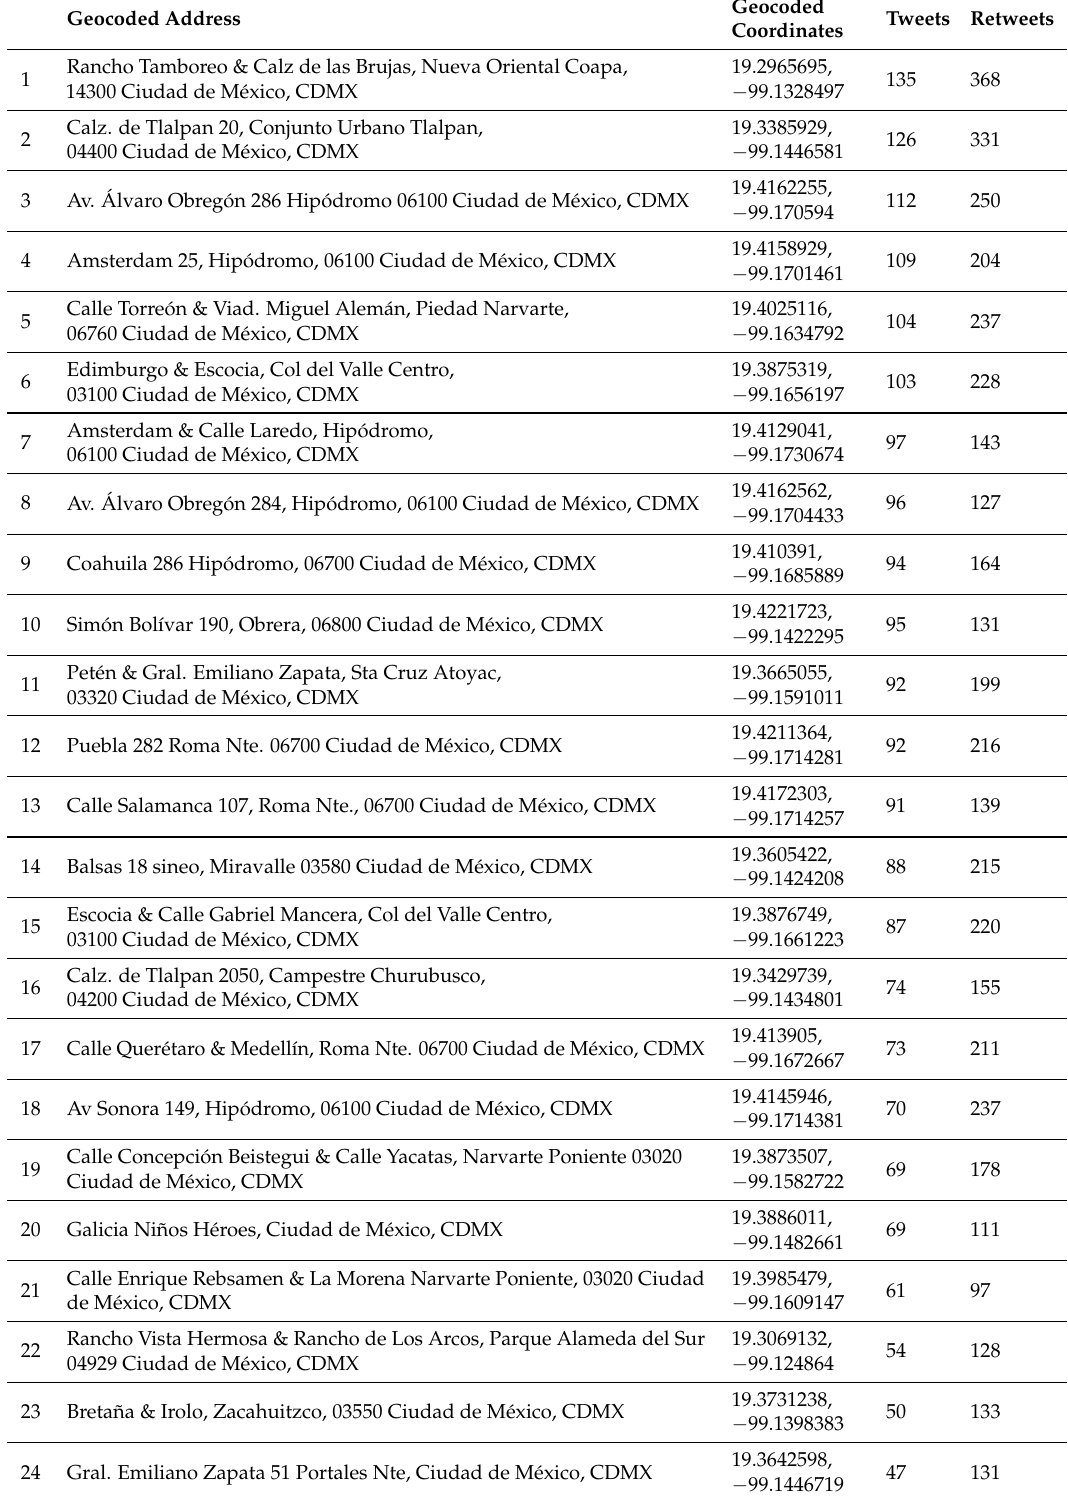
Table 8. Geocoded addresses and coordinates found by the sensor and officially declared as disaster